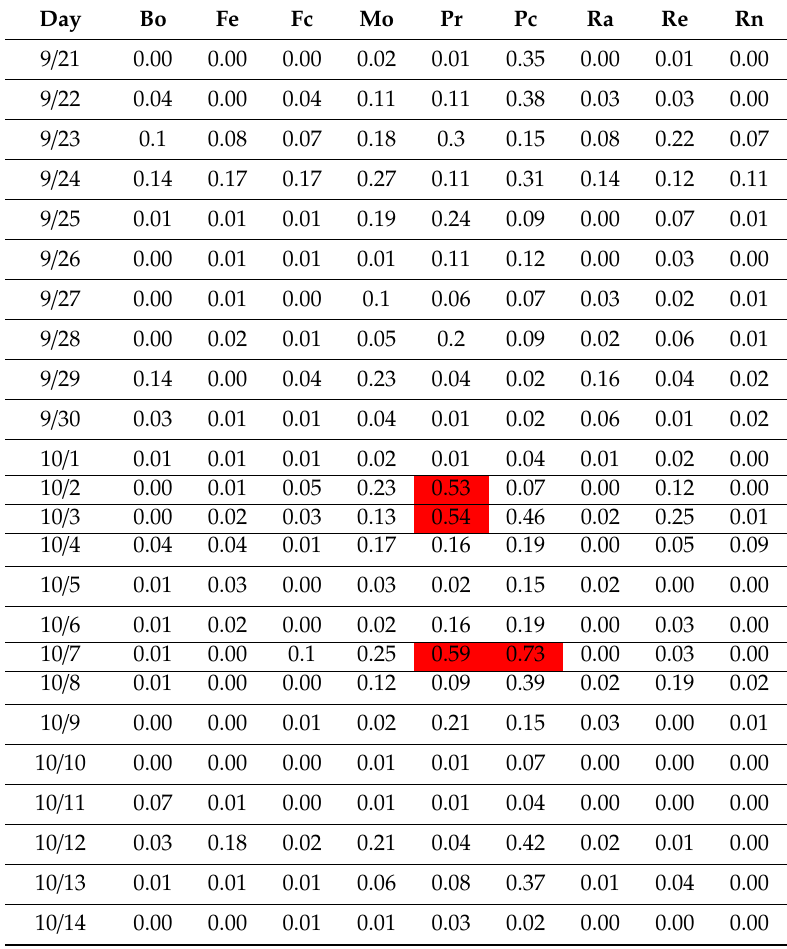
Table 3. Predictions (2019- > 2020): probability